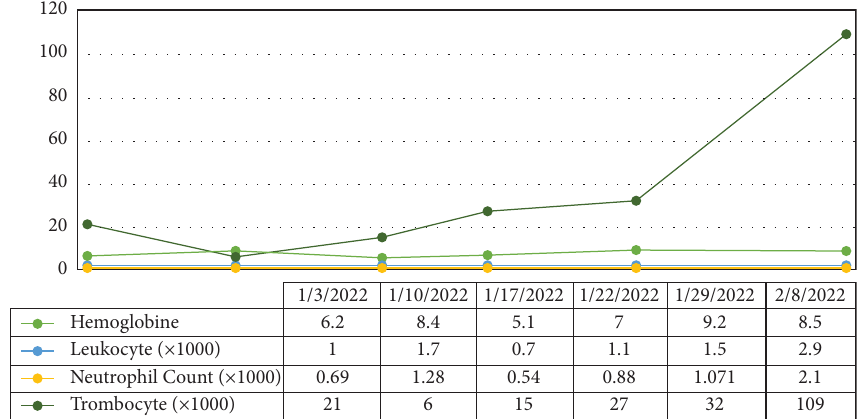
Figure 8: Improvement in peripheral blood parameters following treatment with an antifungal in case